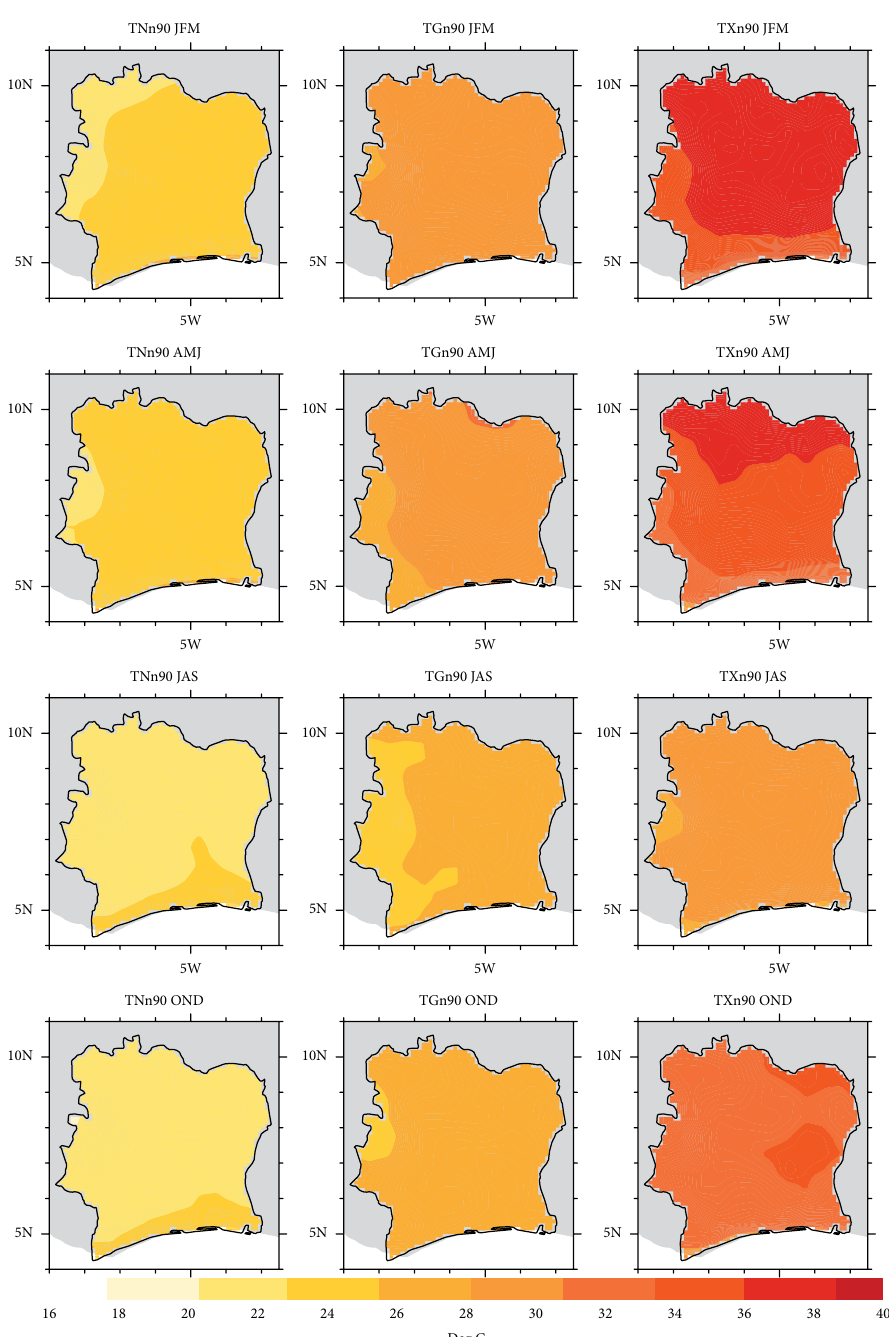
Figure 2: Seasonal distribution of the 90 th percentile of the daily minimum (TNn90), mean (TGn90) and maximum (TXn90) temperature in Côte d’Ivoire during the 1976–2005 period used to calculate the extreme temperature indices (TN90P, HWFI,